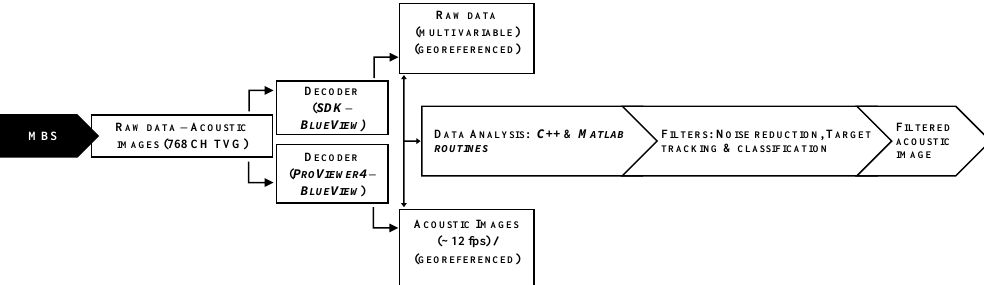
Figure 3. Overview of a data acquisition and processing architecture used to analyze sonar data. The sonar signal is processed by the SDK/ProViewer software (Teledyne BlueView, Seattle, WA, USA),